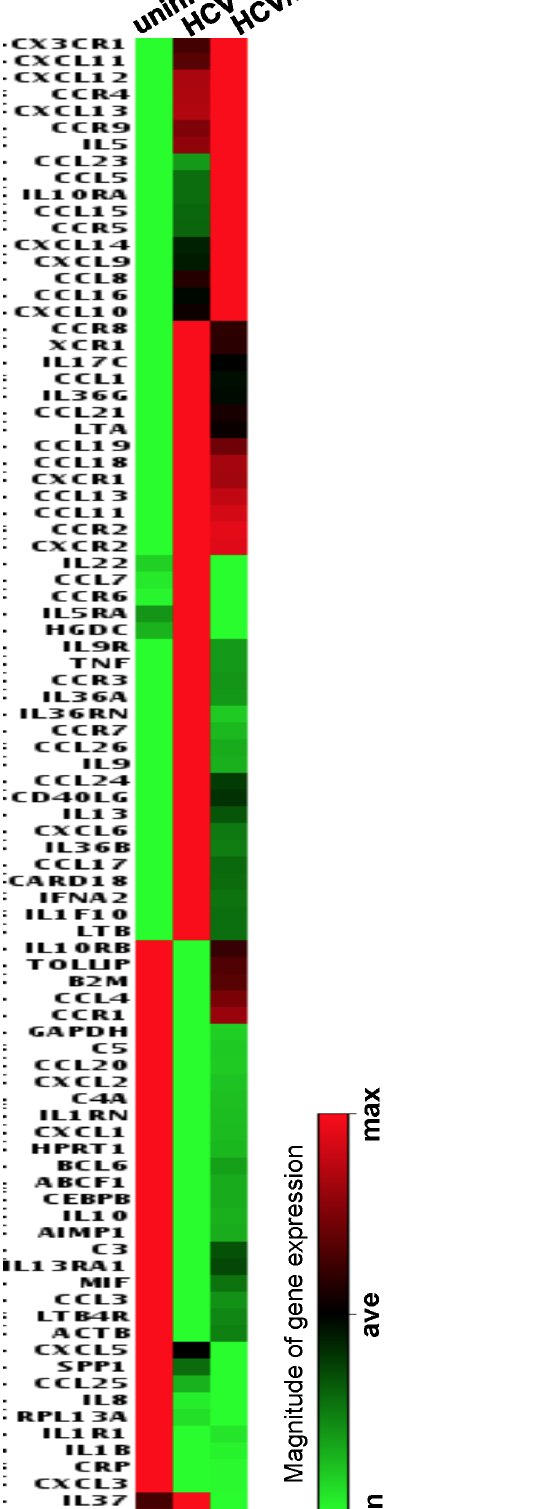
Table 1. The liver biochemistries in HCV infected vs. HCV/HIV- 1 coinfected subjects were: alkaline phosphatase